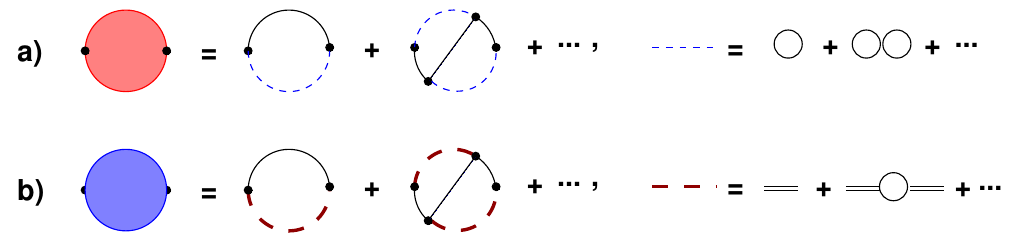
Figure 8 . The shaded blobs in (cid:12)gure 7 describe the propagation of the spectator particle and a) a pair of particles interacting with each other through contact interactions, or b) a dressed dimer. These two lines are connected by particle